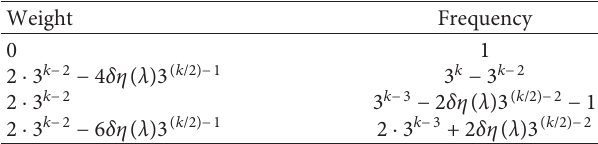
S 0 for Theorem 1 (i).